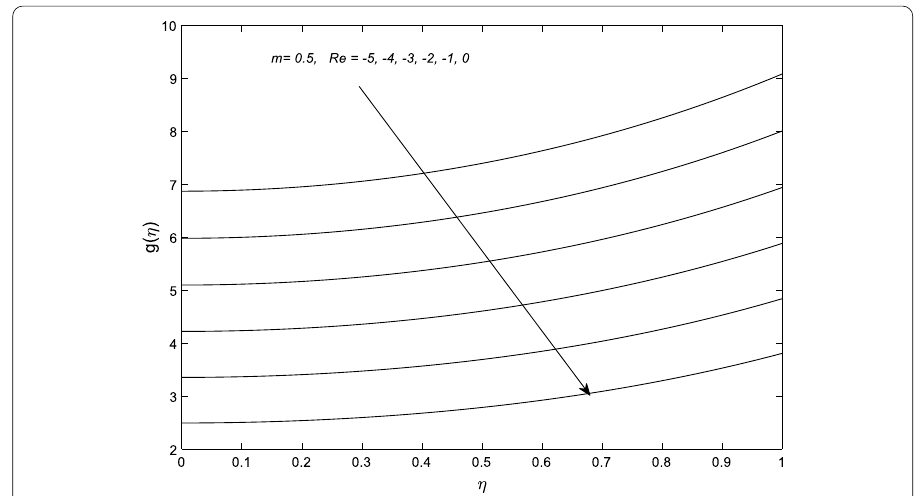
Fig. 3 g is graphed against η for different Re* where Re*